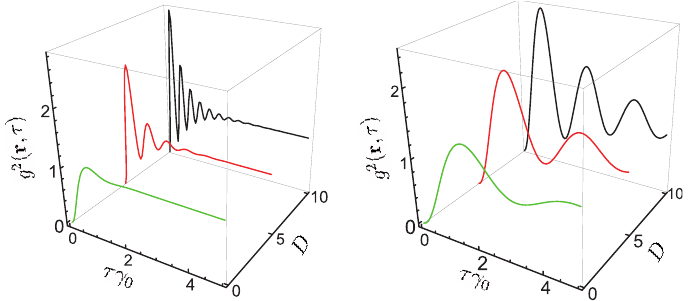
Figure 13. Second-order correlation functions g 2 ( r , τ ) for different values of angle θ at r = 30 nm and different values of the detuning from resonance D (the laser profile is the Lorenzian on). The plots from the left refer to θ = π /4, and the plots from the right correspond to θ = π /2. The antibunching of fluorescent photons in the case of a three-level QE of the Λ